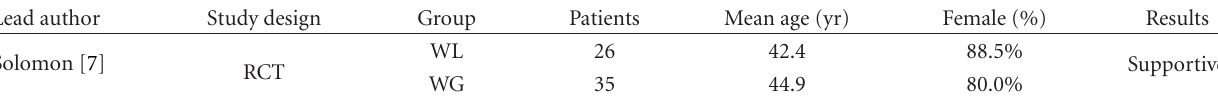
Figure 1: Diagram representing the inclusion and exclusion of PubMed search results. Table 1: Class A studies.